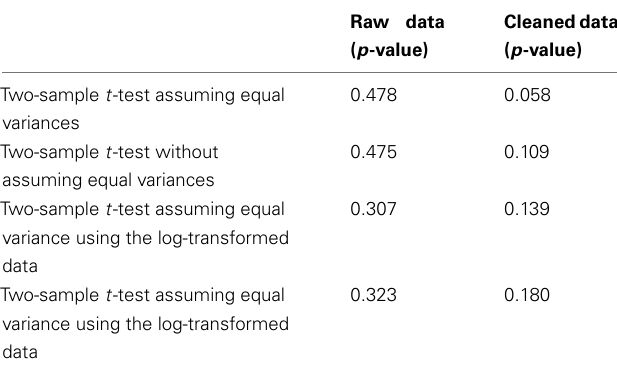
Table 3 | Summary of p -values for the difference in means between Tangrams completion times of athletes and non-athletes under various